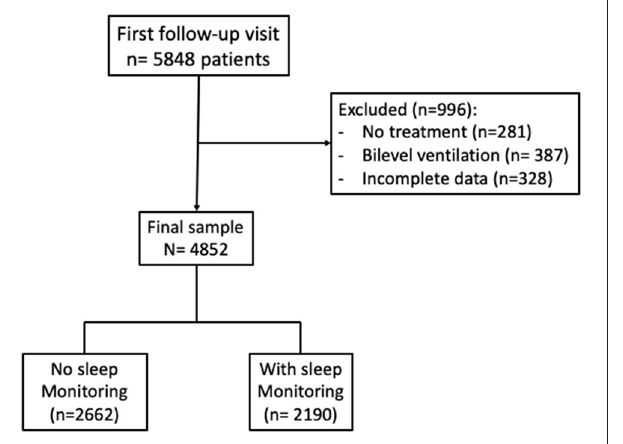
TABLE 2 | Differences at baseline between patients without and with excessive daytime sleepiness (EDS) at the first follow-up visit ( n = 2,190). Variables